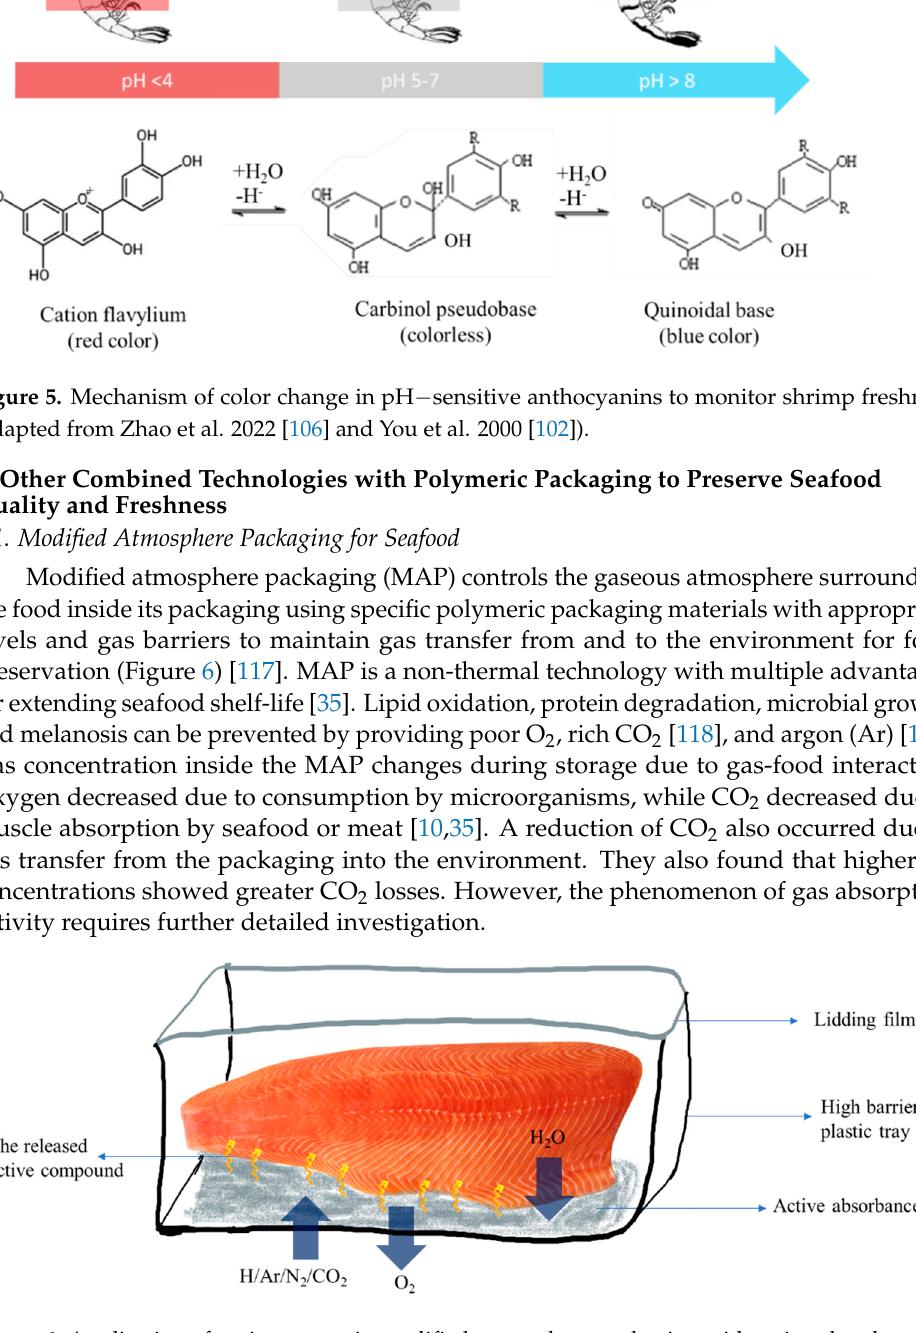
Figure 6. Application of various gases in modified atmosphere packaging with active absorbance in salmon product. Table 3. Previous research on modified atmosphere packaging for seafood products.